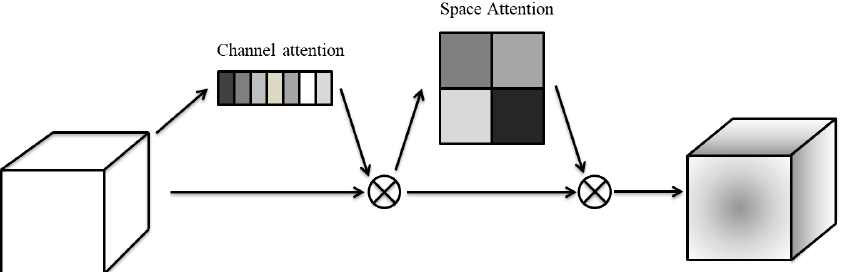
Figure 4. Convolutional block attention module. The specific process is shown below. After inputting the feature, the pooled channel passes through the channel mechanism, providing a global view. Then, convolution and activation provide the channel attention map, as shown above, which is multiplied with the original feature. On this basis, spatial attention is further allocated. The process of spatial attention map acquisition is essentially similar to that of channel acquisition, except that it is pooled in space. Finally, the output is multiplied by the result of the channel attention